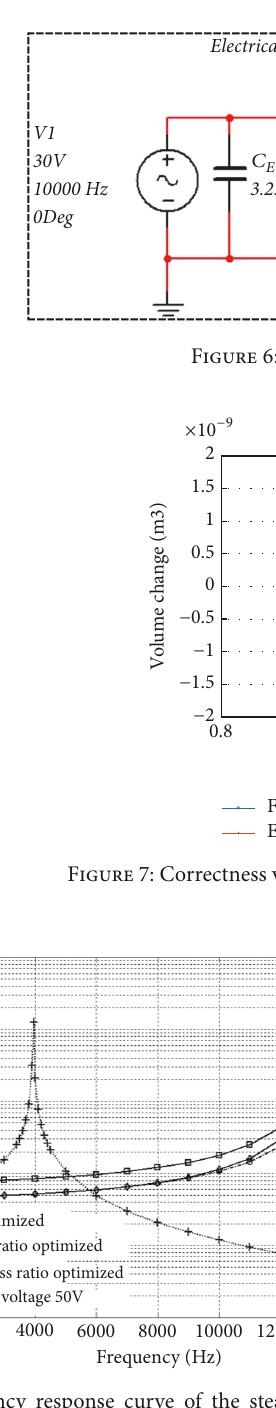
Figure 8: Frequency response curve of the steady-state volume change